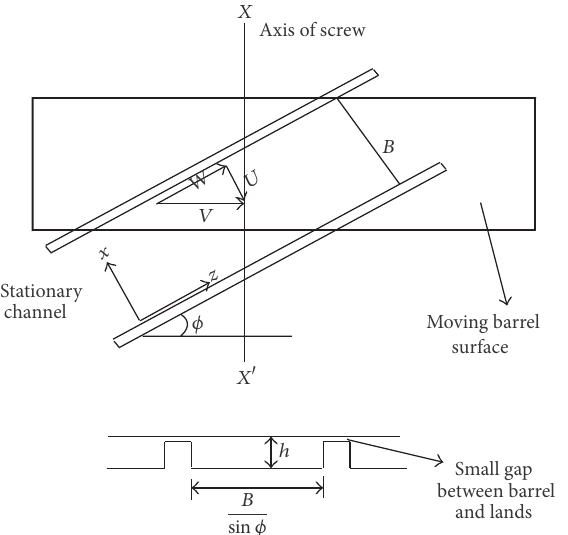
Figure 1: The geometry of the “unwrapped” screw channel and bar- rel